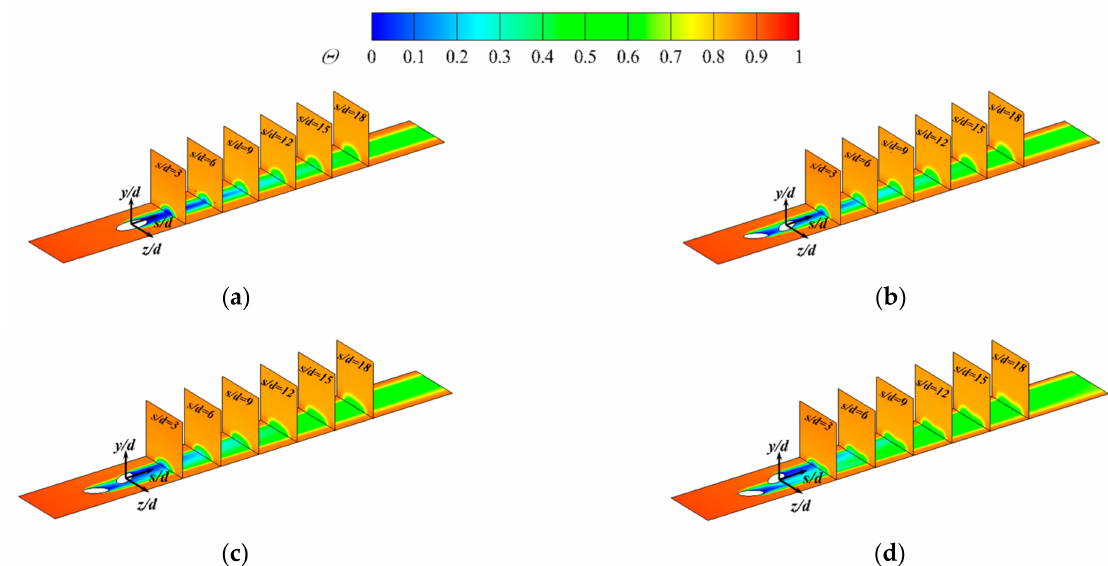
Figure 20. Dimensionless temperature contours in downstream normal sections on the suction side under M = 1.5. ( a ) cylindrical hole, ( b ) Z / d = 0, β = 29 ◦ , ( c ) Z / d = 0.5, β = 29 ◦ , ( d ) Z / d = 1.0, β = 29 ◦ .